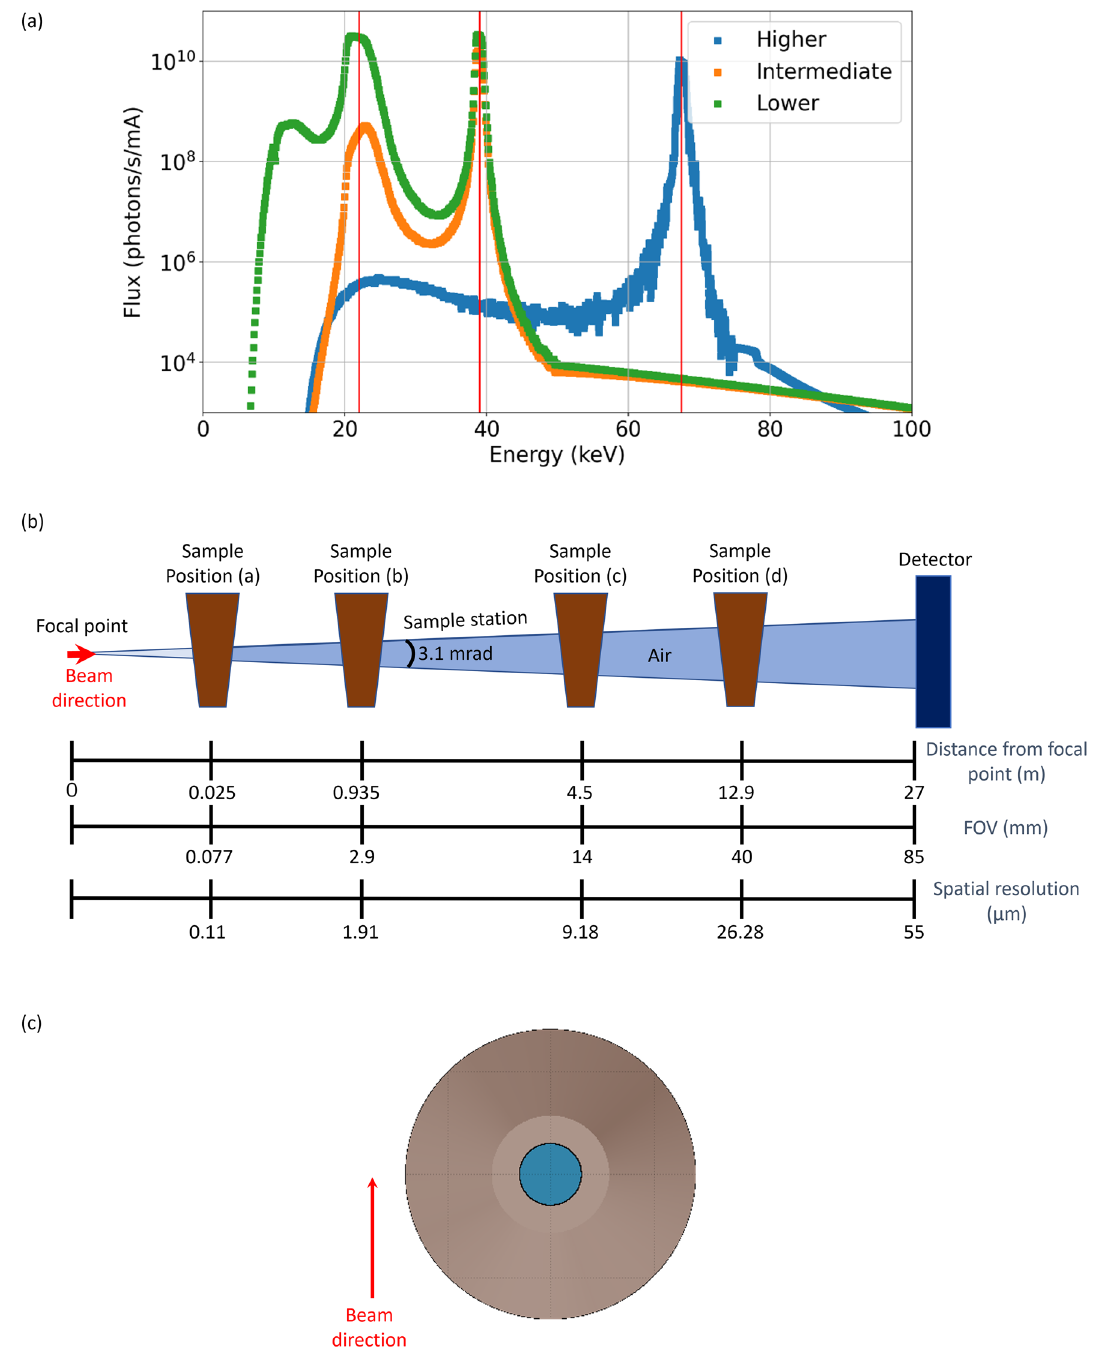
Figure 3. ( a ) Quasi-monochromatic beam spectra of the MOGNO-B configuration after optical focusing and energy selection by KB mirrors, with a 0.7 mm (lower energy) or 7.07 mm (intermediate and higher energies) silicon filter included. ( b ) Schematics of the MOGNO-B beam configuration for four example positions of a soil sample (figure not to scale). ( c ) Schematics of the FLUKA geometry for a soil cross section with a root in the central symmetry axis, which was used for simulations to compare the MOGNO-A and -B